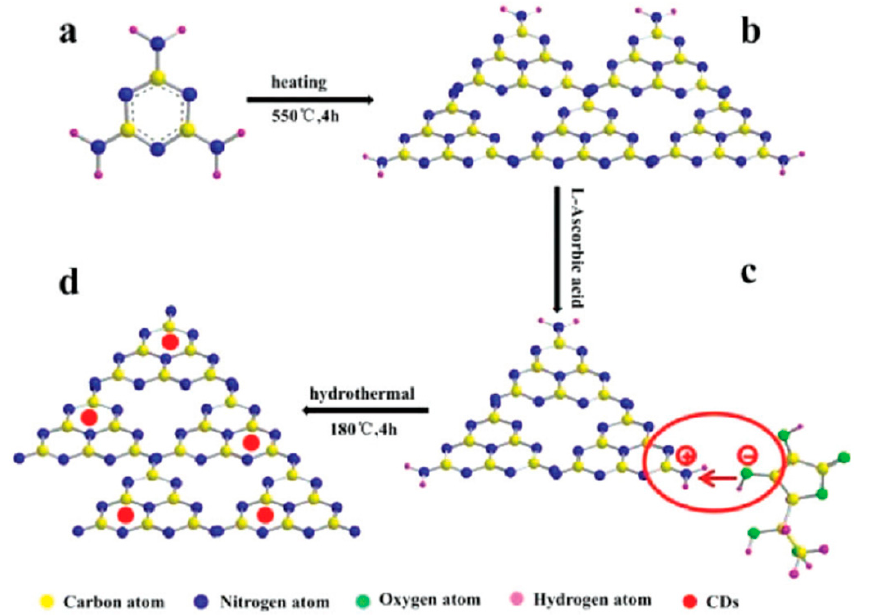
Figure 3. A schematic of the synthesis of CDs / g-C 3 N 4 : ( a ) melamine, ( b ) bulk g-C 3 N 4 , ( c ) L-ascorbic acid / bulk g-C 3 N 4 complexes and ( d ) CDs / g-C 3 N 4 (reproduced with permission from [92]. Copyright Royal Society of Chemistry, 2017).